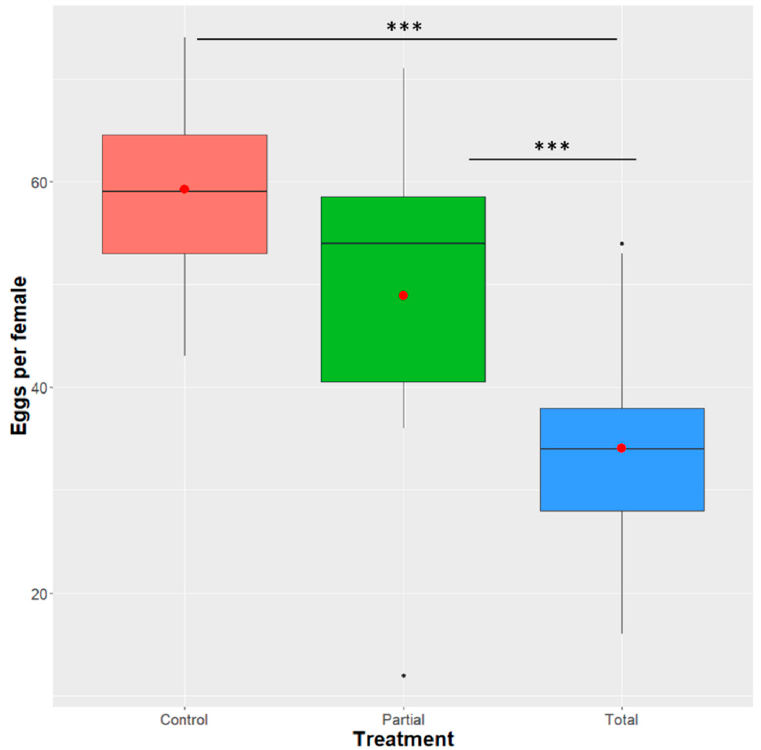
Figure 6. Effect of Enterobacter sp. AA26 on D. suzukii female fecundity. The number of eggs per female are shown in the y-axis for each of the treatment groups and control group. Analysis of fecundity were performed using a GLM (negative binomial family). Boxplots span the interquartile range and whiskers indicate the highest and lowest observations. The line and the dot inside each box represent the median and the mean, respectively. Significant differences between treatment groups are indicated with asterisks (*** p ≤ 0.001, ** p ≤ 0.01, * p ≤ 0.05, ns: p > 0.05; confidence level used: 0.95, alpha = 0.05).